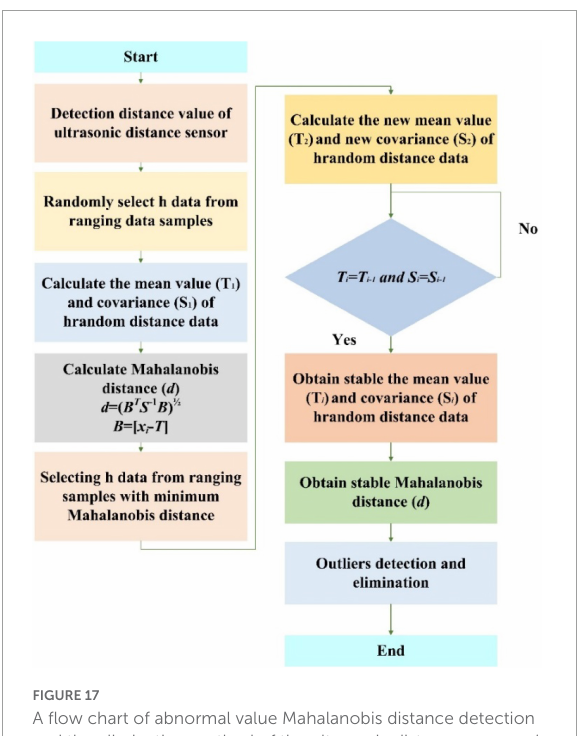
FIGURE17 A flow chart of abnormal value Mahalanobis distance detection and the elimination method of the ultrasonic distance sensor: d , the Mahalanobis distance, h i , the sample size, T , the mean value of the sample data, and S , the covariance matrix of the sample